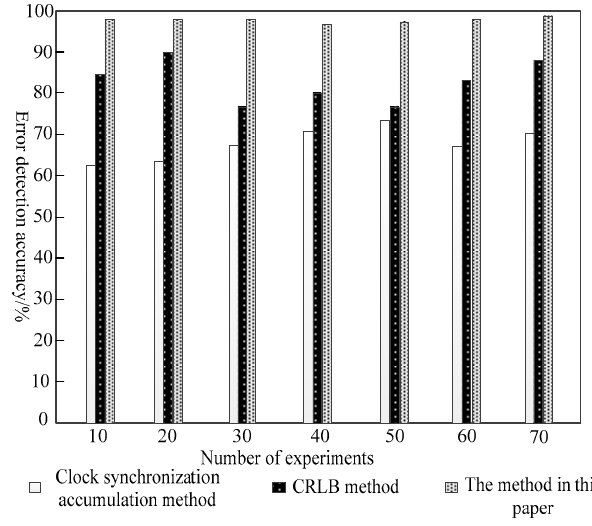
Figure 6. Comparison of error detection accuracy of three methods.